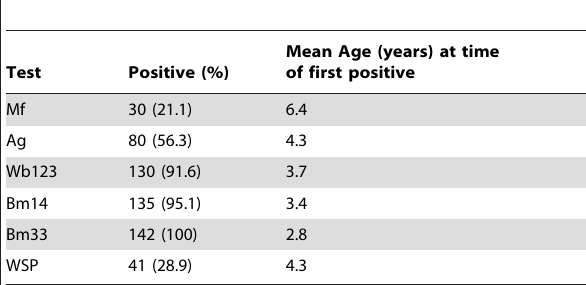
Table 2. Summary of results